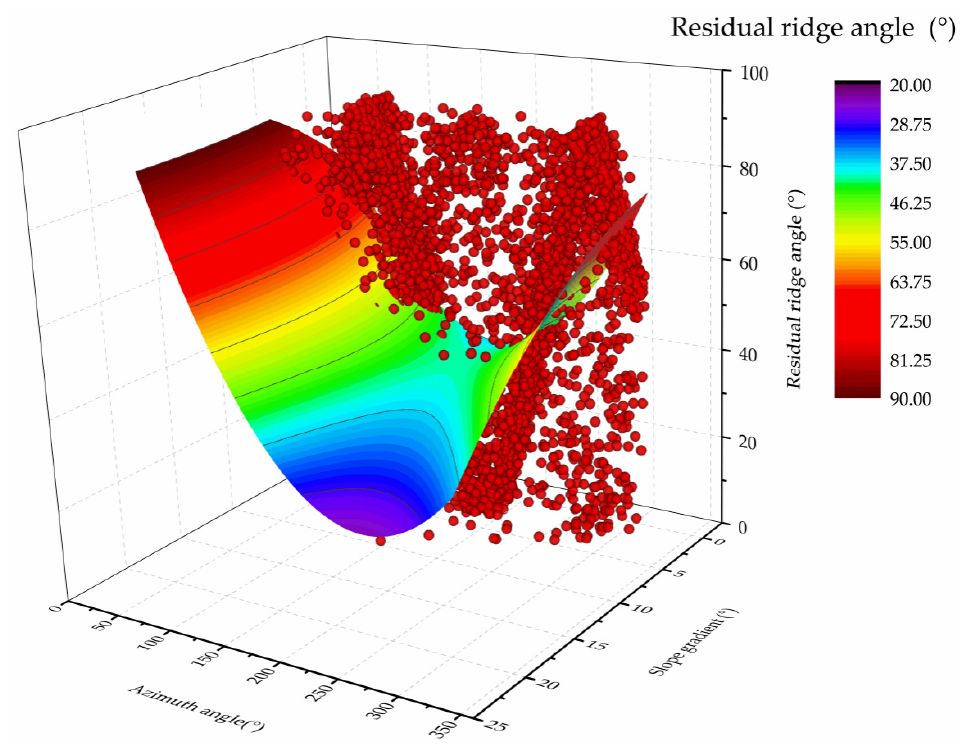
Figure 6. Relationship among slope gradient, azimuth angle and residual ridge angle according to the Poly2D model (n = 472,380).